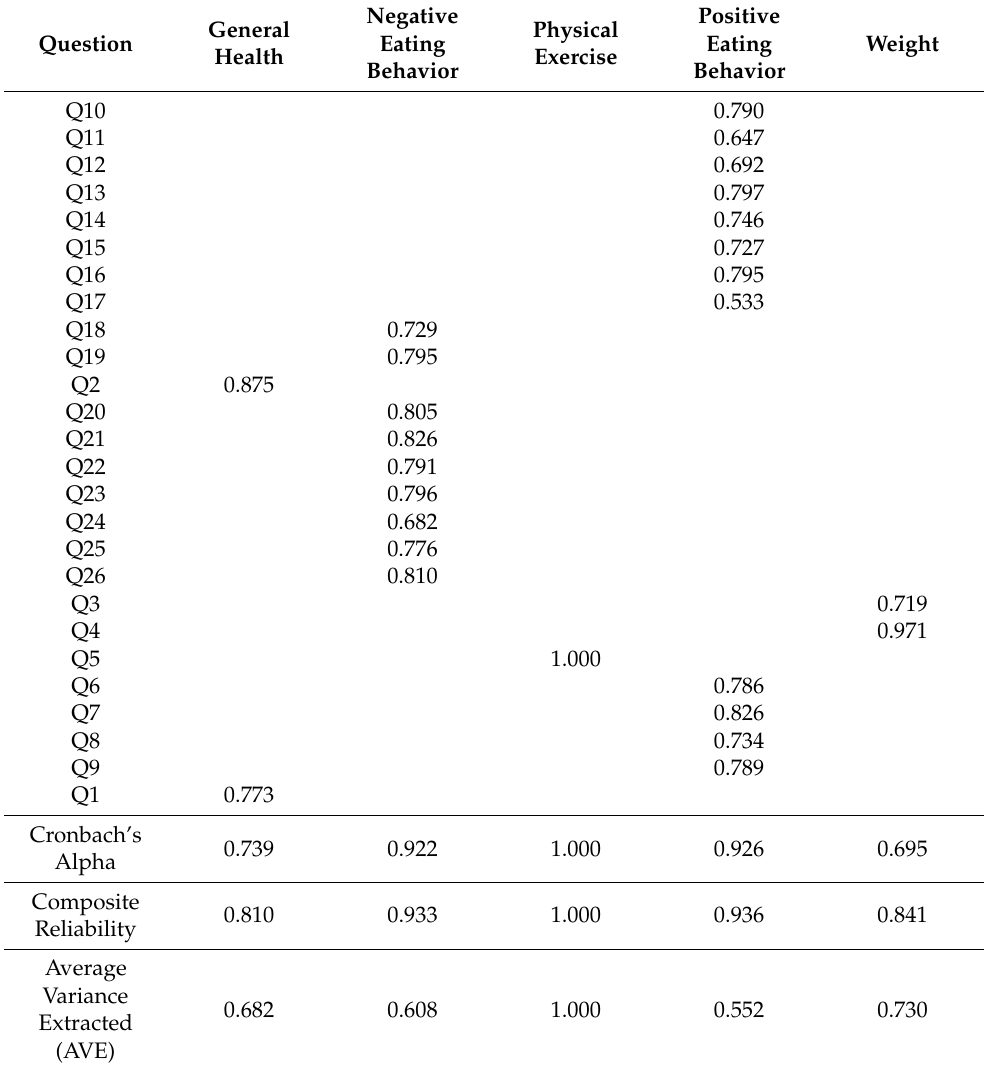
Table 3. Results of the model’s reliability and validity